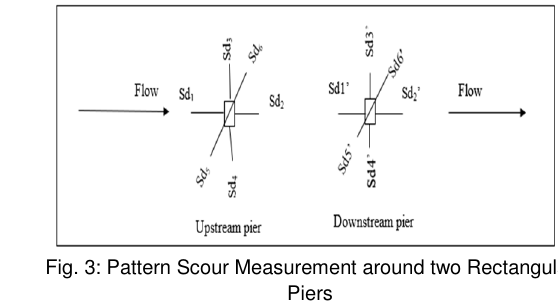
Fig. 3: Pattern Scour Measurement around two Rectangular